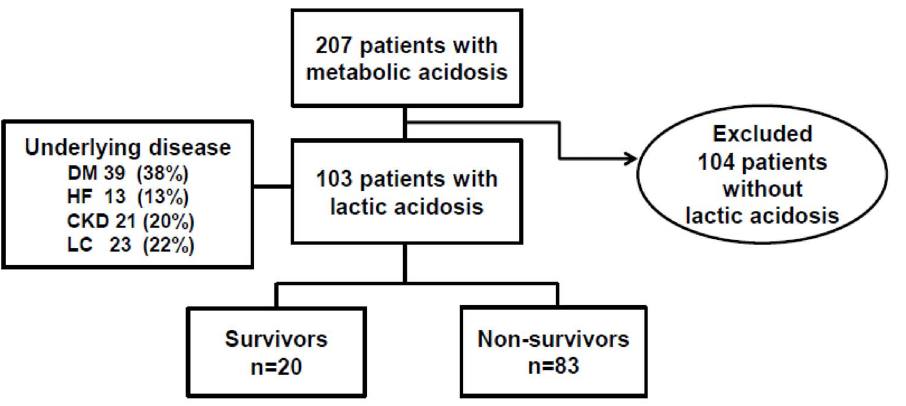
Figure 1. Overview of all of the patients screened and those included in the final analysis. DM, diabetes mellitus; HF, heart failure; CKD, chronic kidney disease, LC, liver cirrhosis.